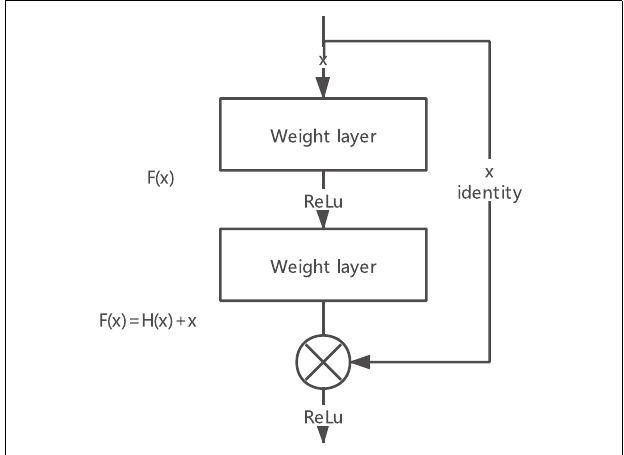
FIGURE 2 | Principle of the residual module.